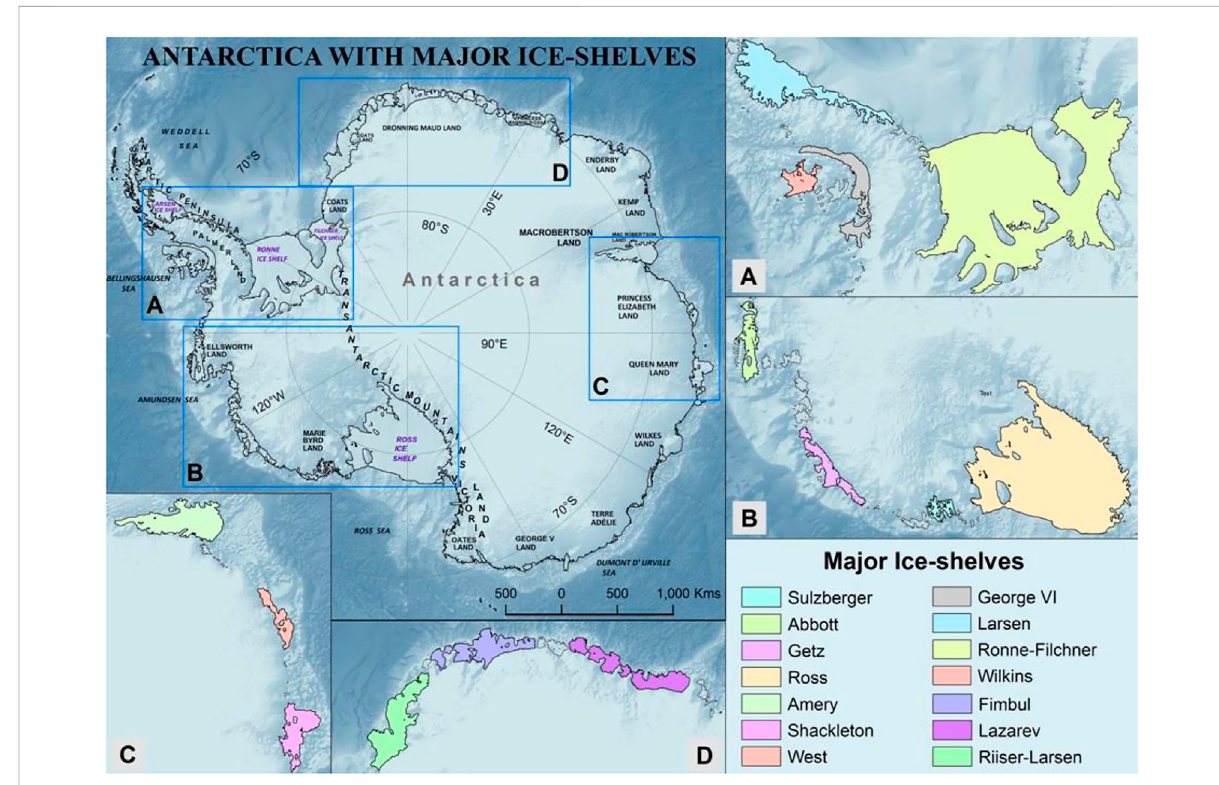
FIGURE 1 Map of Antarctic ice shelves referred to in this study. Ice shelves in different region: Region- (A – D) are inferred in the text.